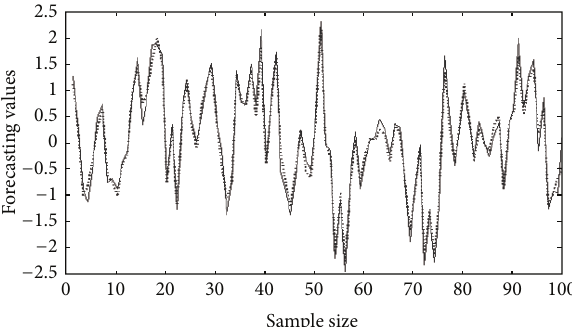
Figure 4: Comparison with true values (dashed line) and forecast- ing values (pointed line).